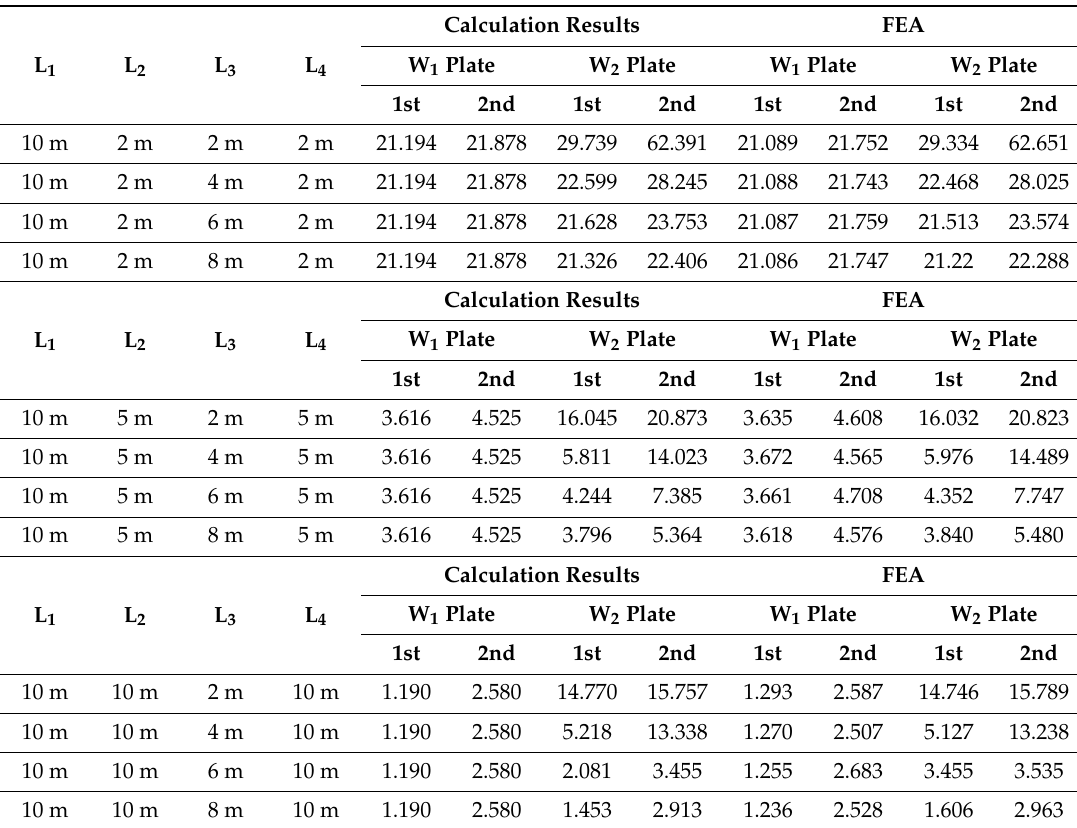
Table 6. The comparison of results (unit: